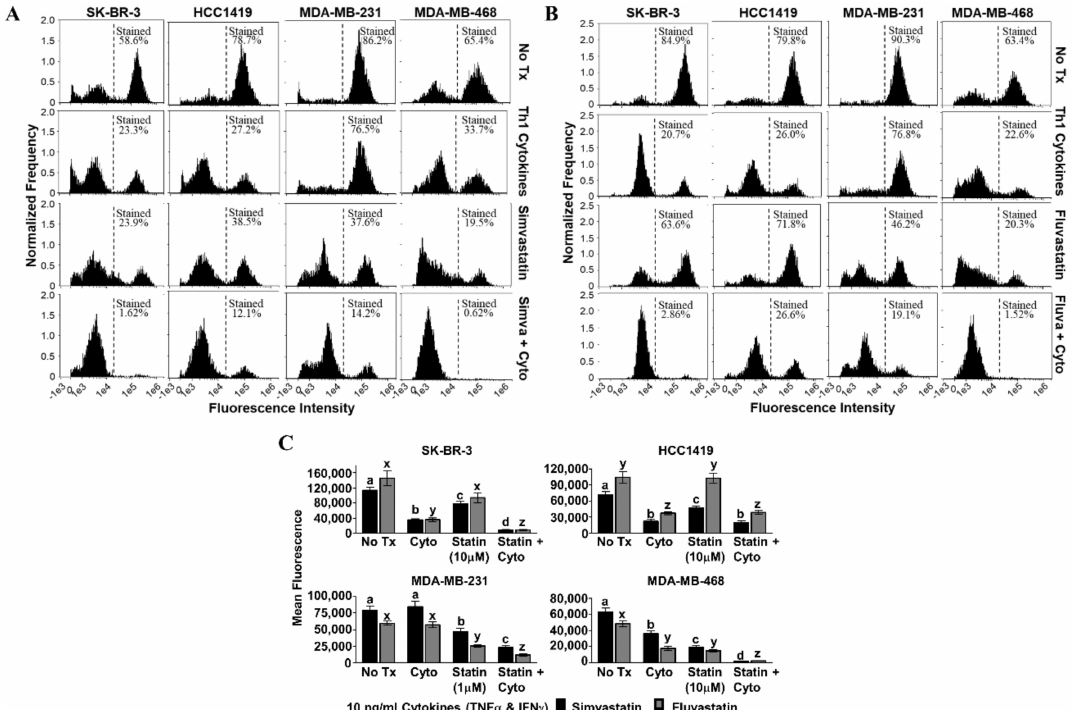
Figure 4. Statin drugs plus Th1 cytokines maximize mitochondrial membrane depolarization as assessed by tetramethylrhodamine ethyl ester (TMRE) staining. SK-BR-3, HCC1419, MDA-MB-231, and MDA-MB-468 human breast cancer cell lines were cultured with no additives (No Tx), treated with recombinant Th1 cytokines (TNF- α and IFN- γ , 10 ng / mL each), a statin drug ( A ) Simvastatin or ( B ) Fluvastatin (1 µ M MDA-MB-231; 10 µ M remaining cell lines), or the combination of Th1